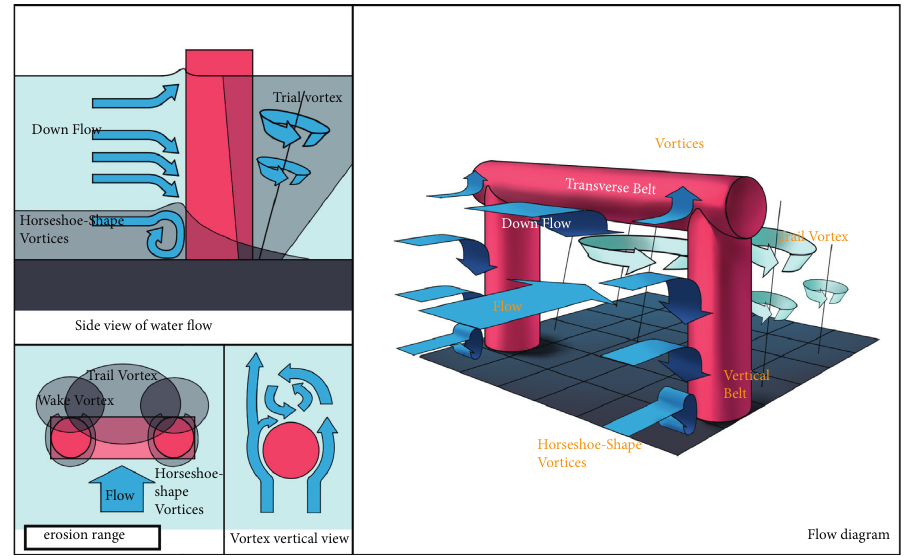
Figure 6: The flow structure at the geogrid. Table 2: Experimental data of tailings erosion with the reinforcement spacing of 2.5cm.